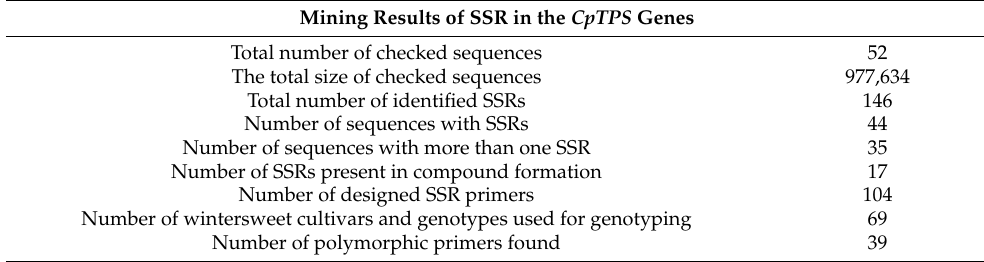
Figure 2. Phylogenetic relationship of CpTPS genes. MEGA 7.0 software was used to generate a phylogenetic tree using ML method. The blue, green, yellow, purple and orange branches represent the TPS-a, TPS-b, TPS-c, TPS-e/f and TPS-g subfamilies.